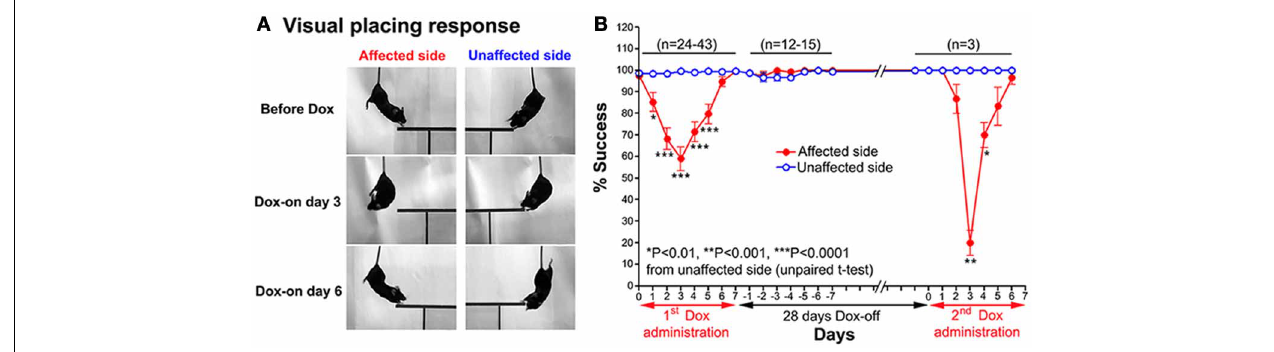
FIGURE 2 | (A) Series of photographs showing the effect of the Tet-induced tetanus neurotoxin-expressing system on the visual placing response toward the affected side (Dox-on day 3) and disappearance of the effect (Dox-on day 6), compared with the unaffected side. (B) Effect of the